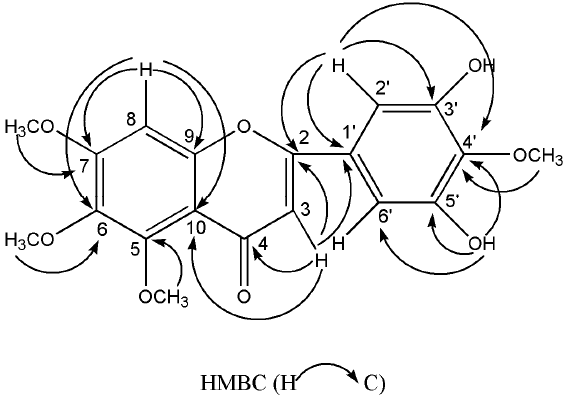
Figure 2. Key HMBC correlations of compound 6 . Table 1. 1 H and 13 C-NMR data of flavone 6 in DMSO- d 6 .